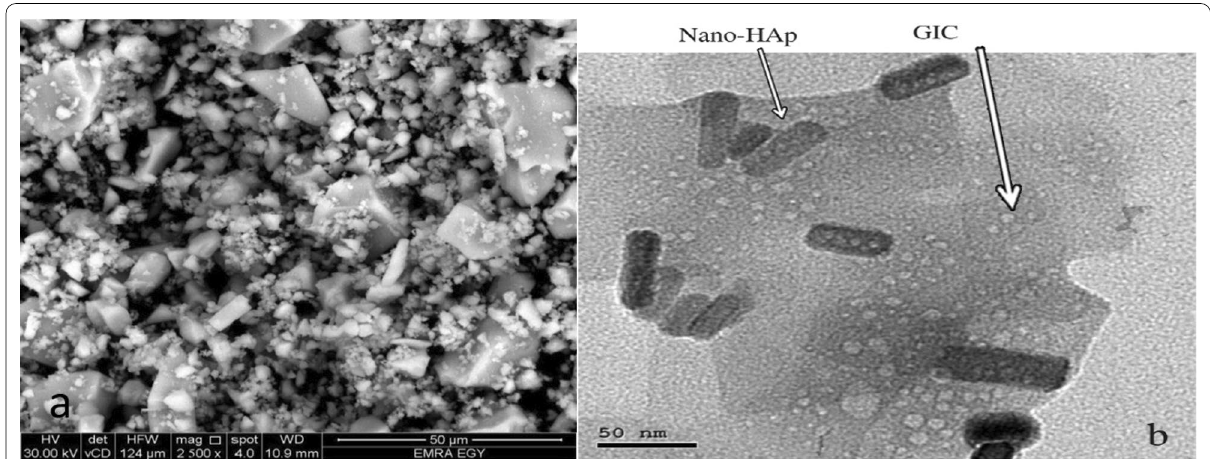
Fig. 5 SEM ( a ) and TEM ( b ) photomicrographs for the prepared nano-HA-GIC powder